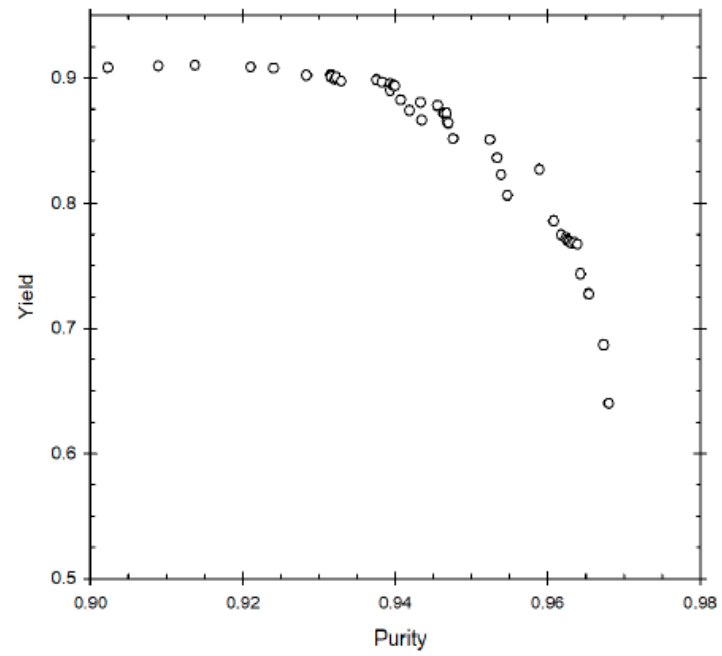
Figure 5. Design-stage optimization. Case 2.1 Maximization of Yield and Purity.